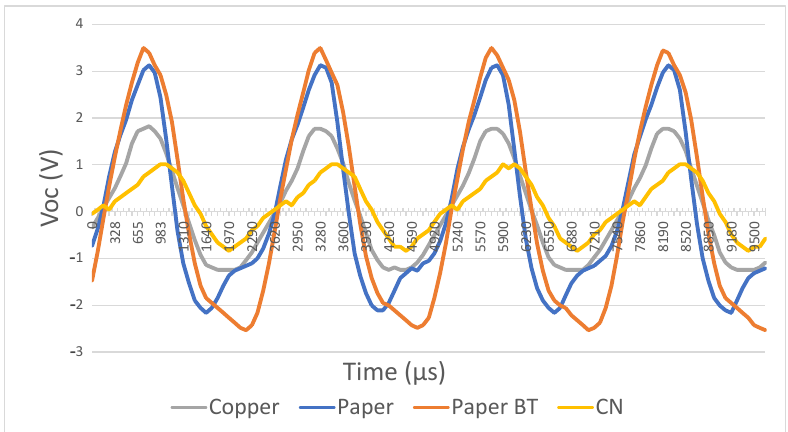
Figure 15. Open circuit voltage for different dielectric